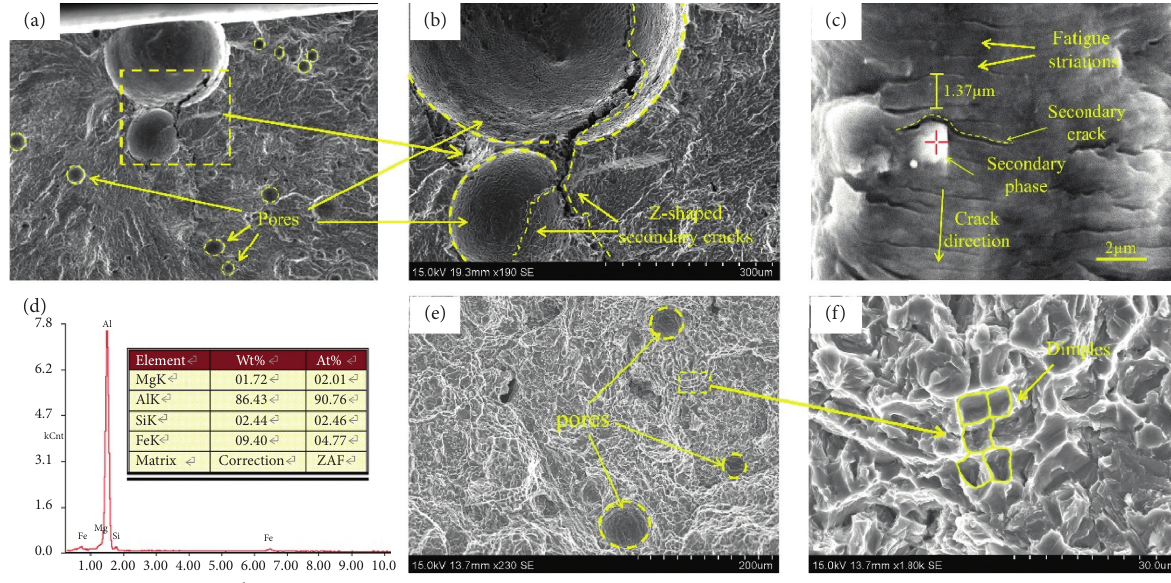
Figure 8: Fatigue fracture morphology of WJ under stress amplitude of 85.5 MPa. (a) Crack source and crack propagation region. (b) Partial enlargement of Figure 8(a). (c) Fatigue striations morphology in the crack propagation region. (d) Energy spectrum analysis result of the secondary phase particle in (c). (e) Transient region. (f) Partial enlargement of